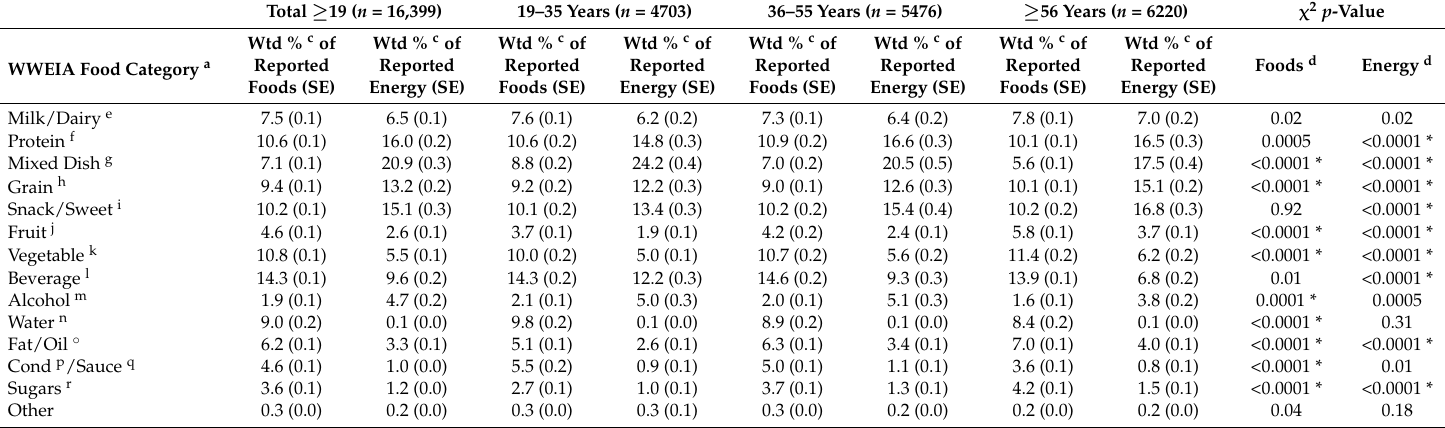
Table 2. Broad WWEIA food category a intake comparisons by frequency and energy among U.S. adults ≥ 19 years using NHANES 2007–2012 b